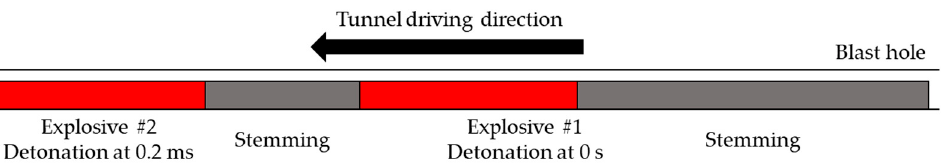
Figure 8. Schematic of charging pattern in the modified LLB method using the deck charge technique.